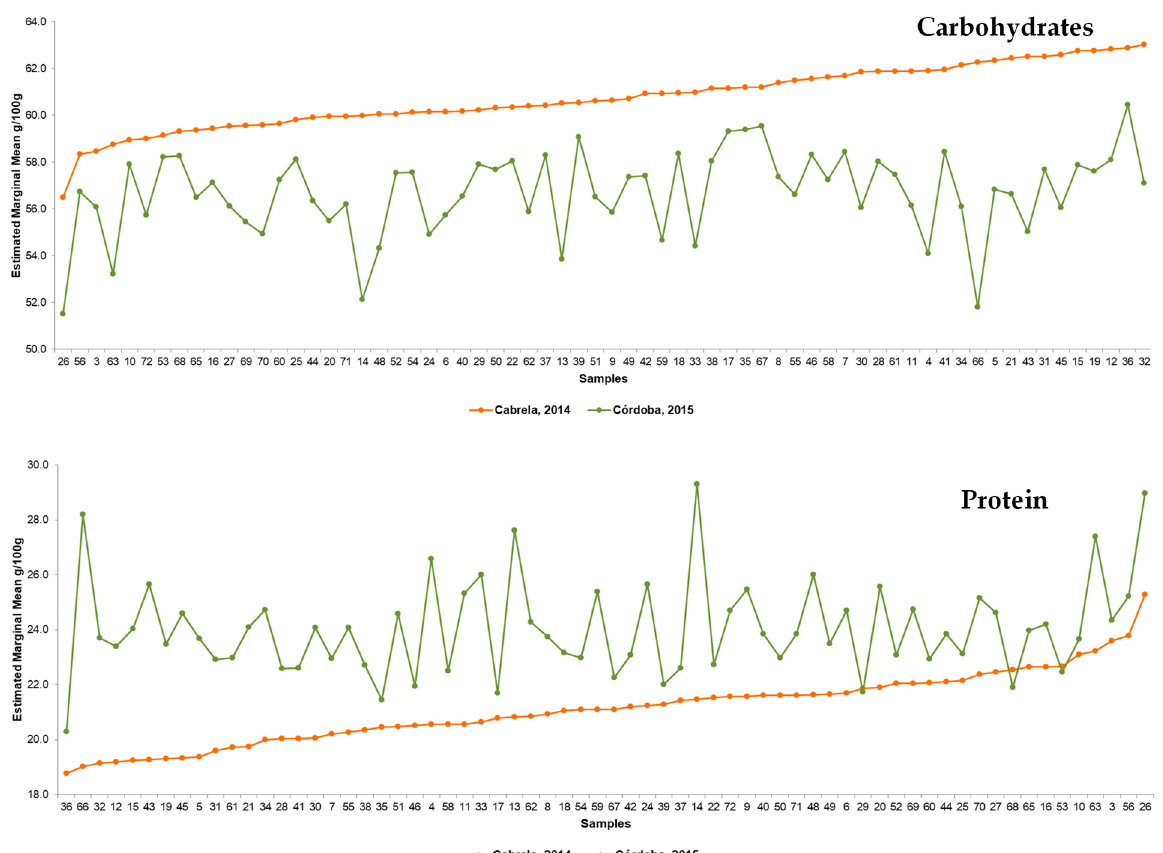
Figure 2. Graphic representations of the genotype × environment interaction effects in the nutritional parameters analyzed. Common bean samples collected from Cabrela field trial were ranked according to increasing values of moisture, ash, fat, fiber, carbohydrates and protein contents.